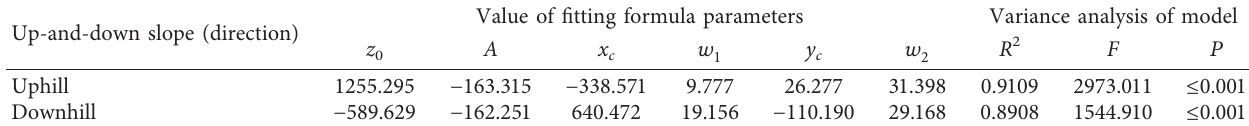
Table 9: Fitting formula parameters and fitting model ANOVA.